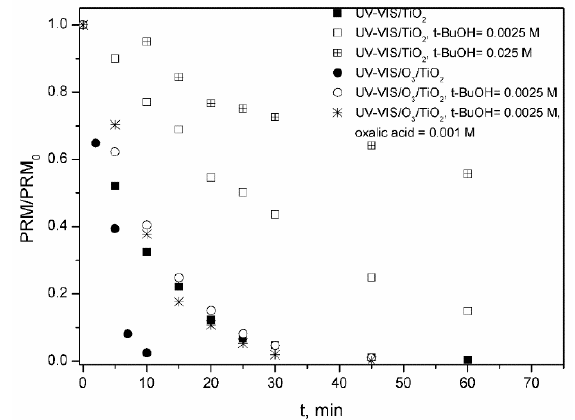
Figure 5. PRM removal in the presence and absence of t-butanol in UV-Vis/TiO 2 and UV-Vis/TiO 2 /O 3 systems and in the presence oxalic acid in UV-Vis/TiO 2 /O 3 system. Experimental conditions: Ultrapure water; [PRM] 0 = 5 mg L − 1 ; pH 0 ~6 (natural pH); Q m,O3 = 3.3 mg min − 1 ; T = 20–30 °C; I UV-Vis = 8.2 × 10 − 5 Einstein L − 1 s − 1 .